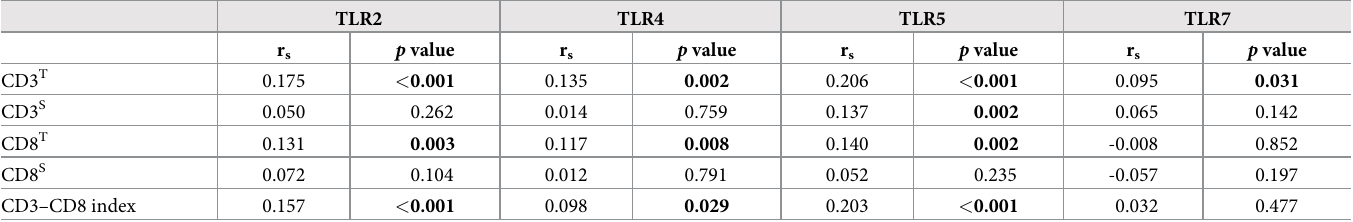
Table 2. Correlations between the immunoexpressions of TLRs and the tumoral and stromal densities of CD3 and CD8 cells and CD3–CD8 tumor–stroma index in 549 CRC patients.